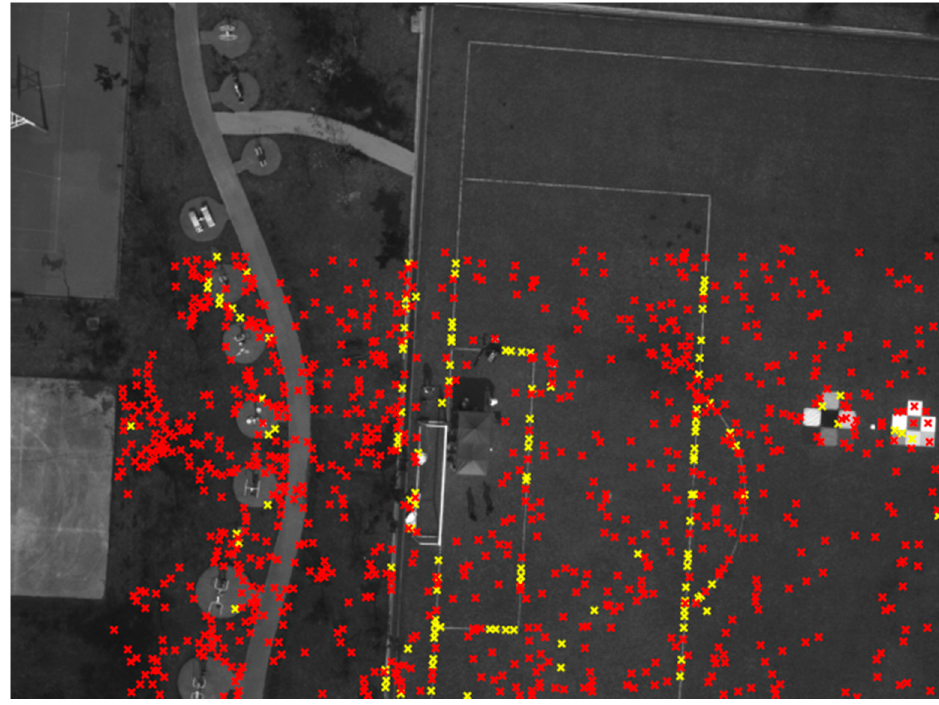
Figure 11. An example of accepted tie points (red ×’s) among all tie points.